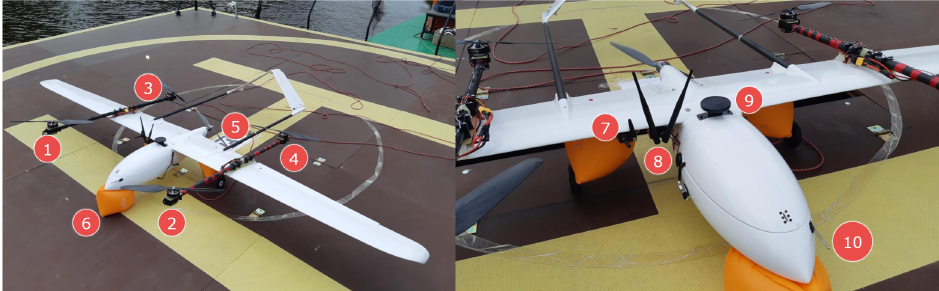
Figure 2. The Albatros VTOL UAV, 1,2,3,4—MC mode motors, 5—a FW pusher motor, 6—a inflatable buoy, 7—a 868MHz radiomodem, 8—a 2.4GHz radiomodem, 9—a GNSS antenna, 10—a pitot